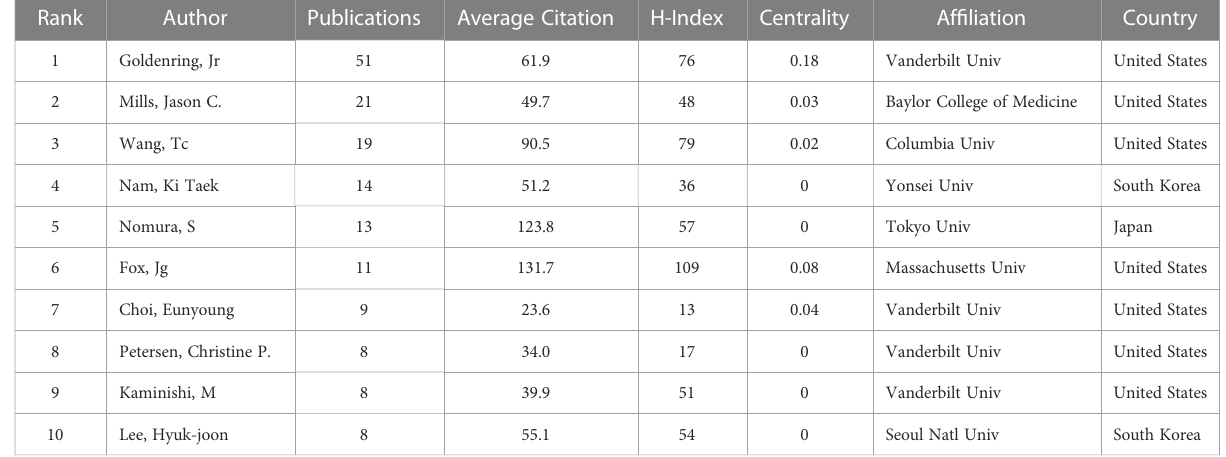
TABLE 3 The top 10 productive authors involved in SPEM-GC research.